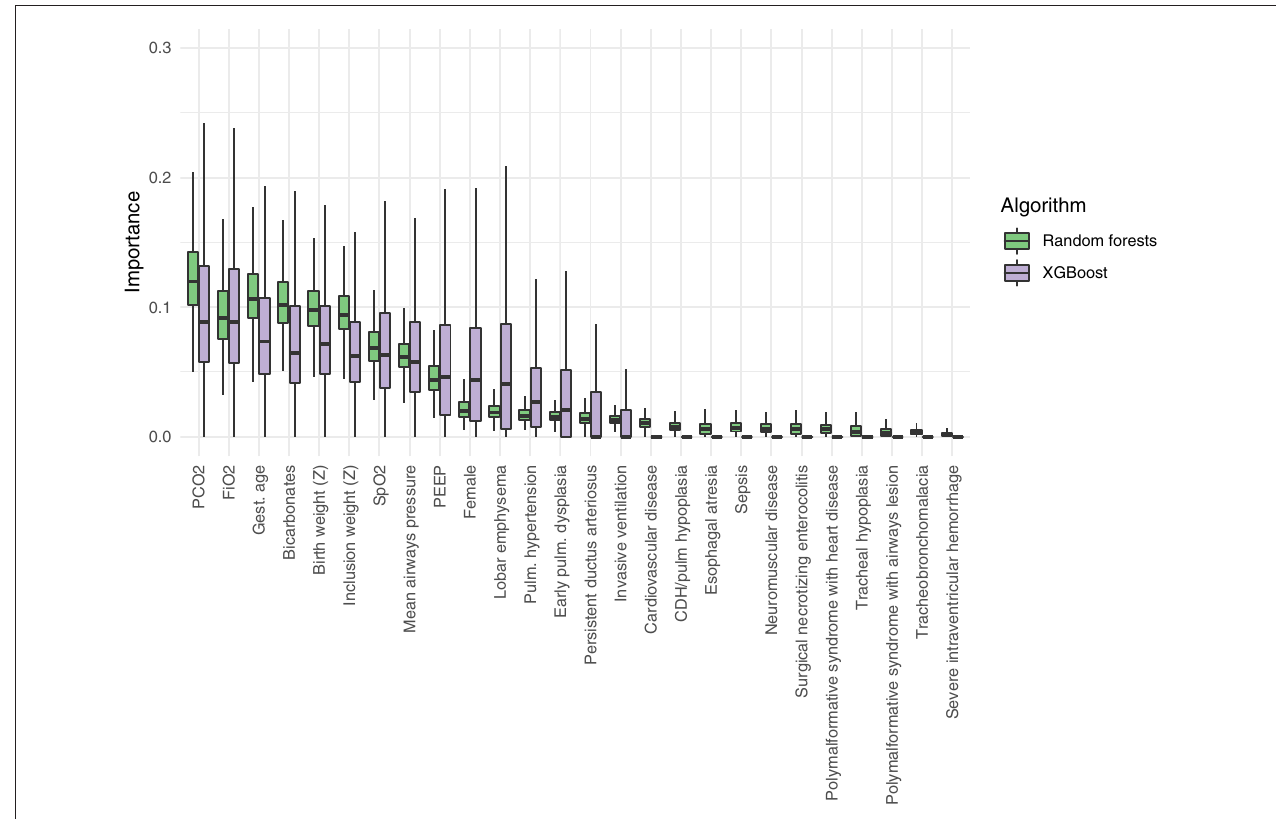
FIGURE 4 | Relative importance of the different variables included in the random forests and in the extreme gradient boosting models (XGBoost). PEEP, positive end expiratory pressure; CDH, congenital diaphragmatic hernia; Z , Z